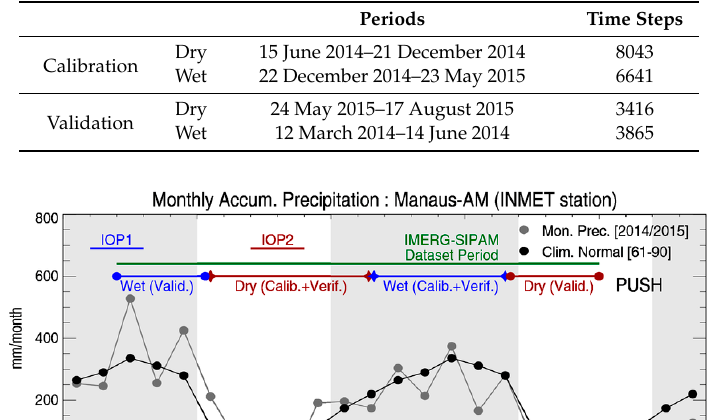
Table 1. Precipitation Uncertainties for Satellite Hydrology (PUSH) calibration and validation periods during the wet and dry seasons.